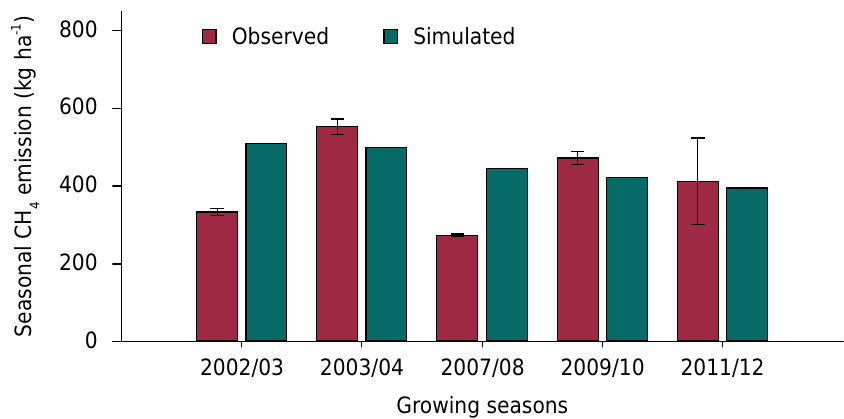
Figure 5. Observed and simulated seasonal soil methane (CH 4 ) emissions under a no-tillage system in a long-term experiment in southern Brazil. Error bars represent standard